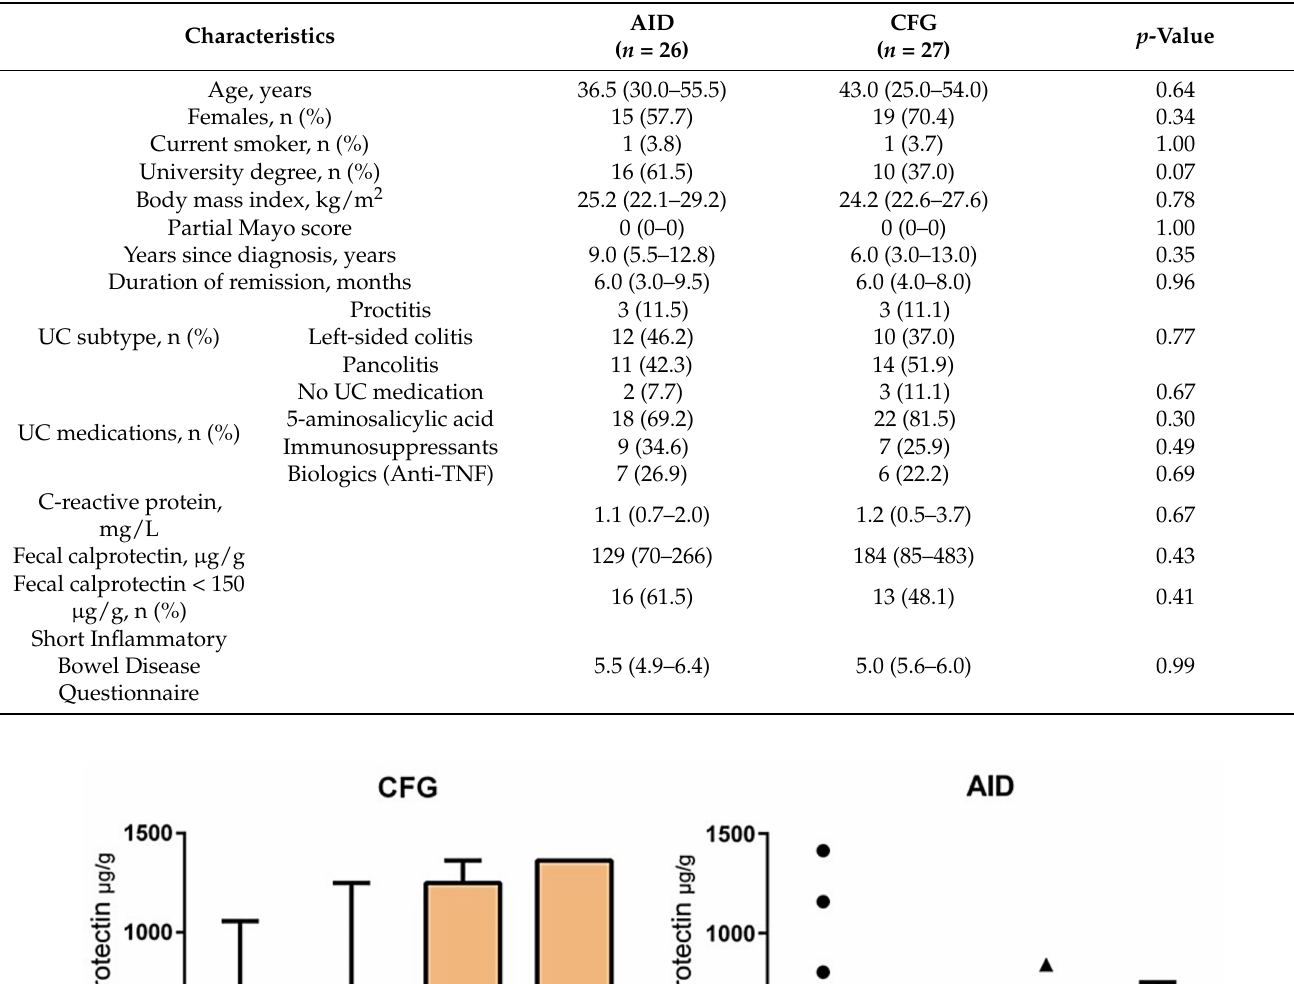
Table 1. Demographic and clinical characteristics of study participants at baseline.